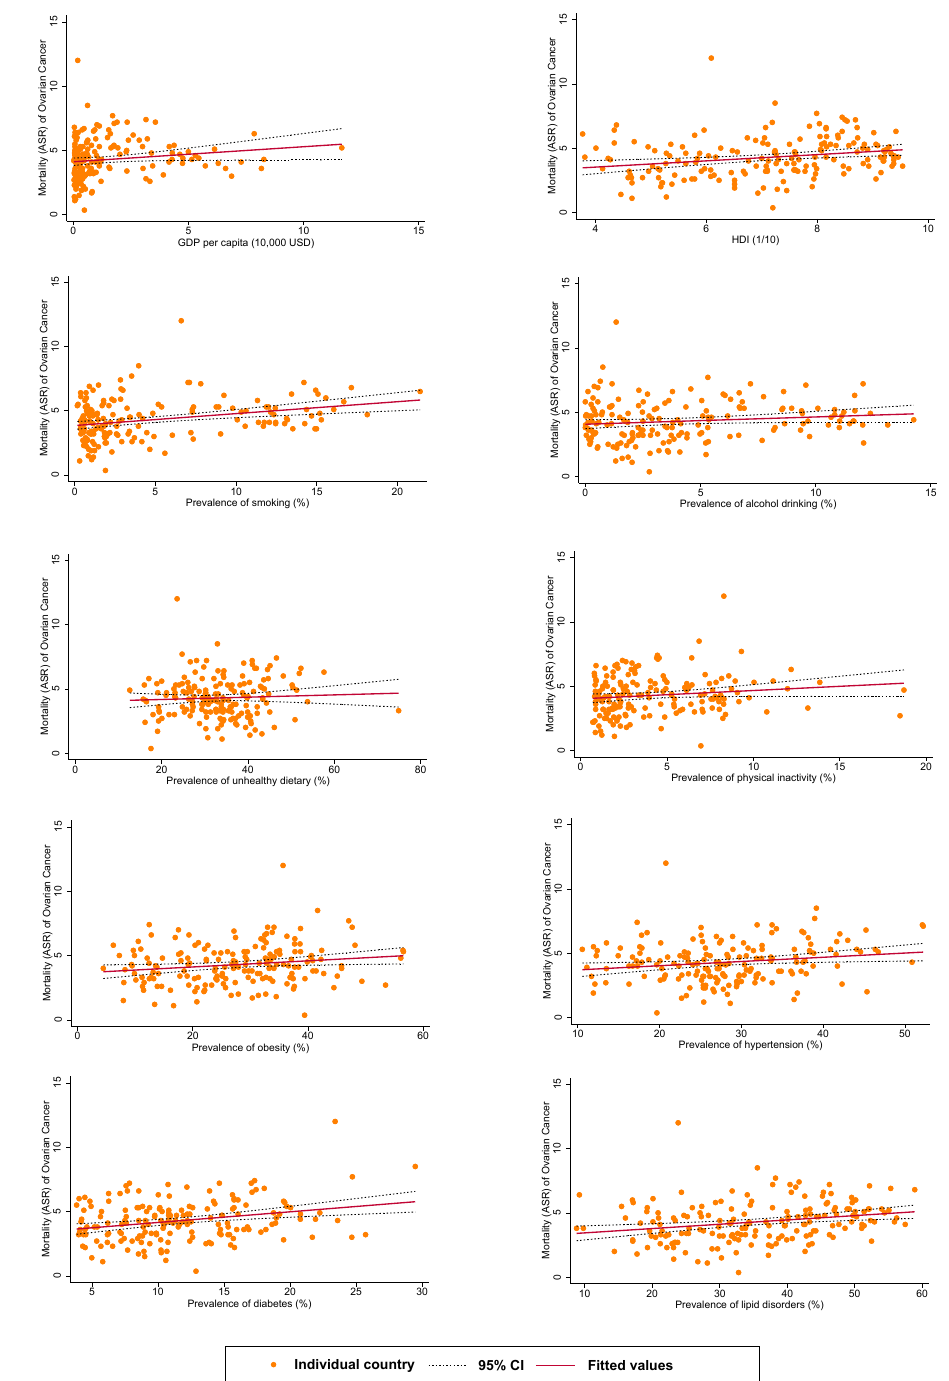
Figure 3. Associations between risk factors and mortality of ovarian